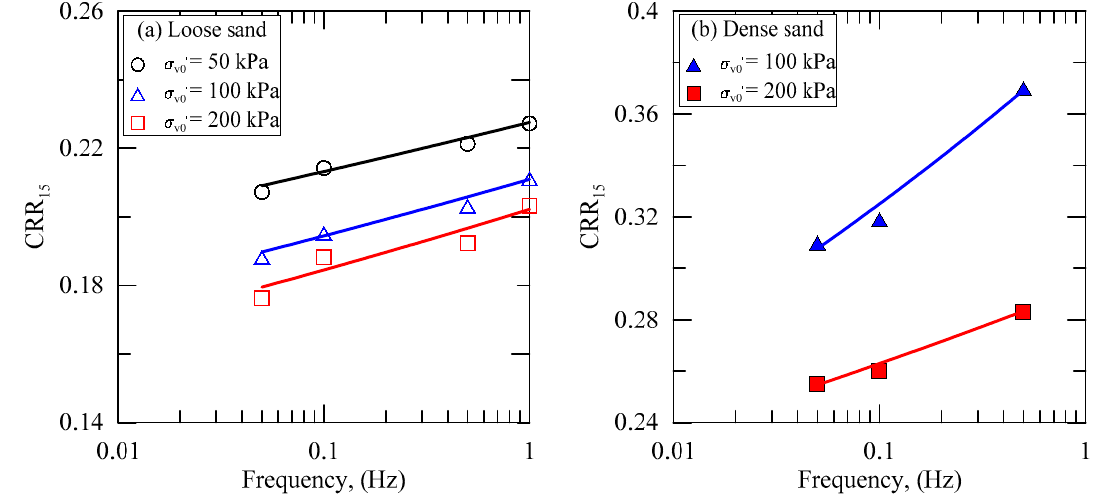
Figure 8. Effects of loading frequency ( a ) loose sand and ( b ) dense sand on cyclic resistance.